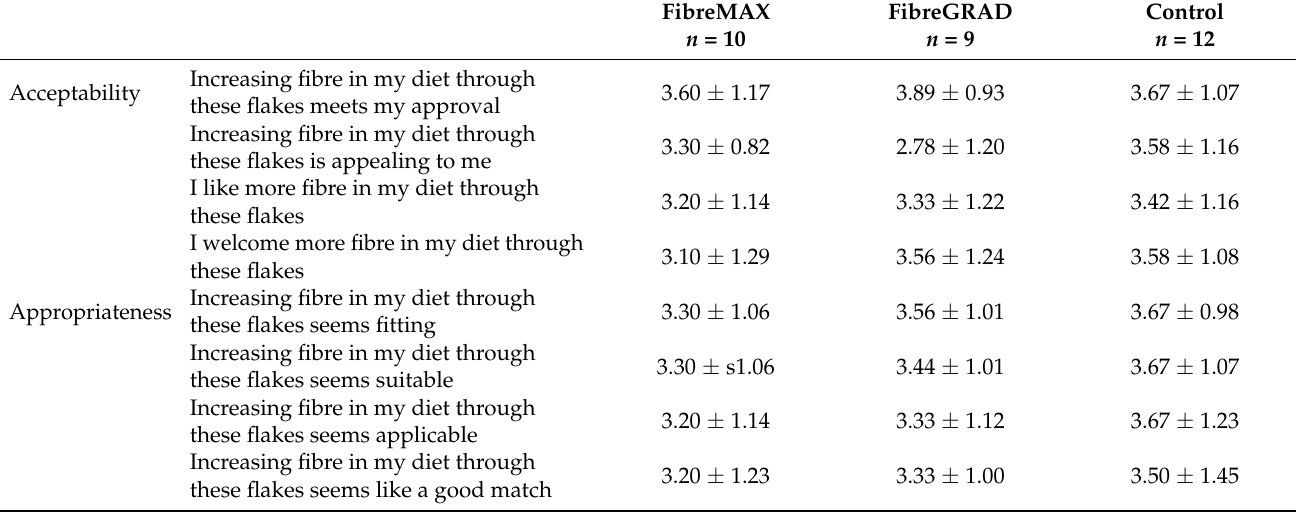
Table 4. Results of the survey assessing participants acceptability, appropriateness, and feasibility with the MAXtrial. Values are mean ± SD. Scores: 1 = completely disagree, 2 = disagree, 3 =